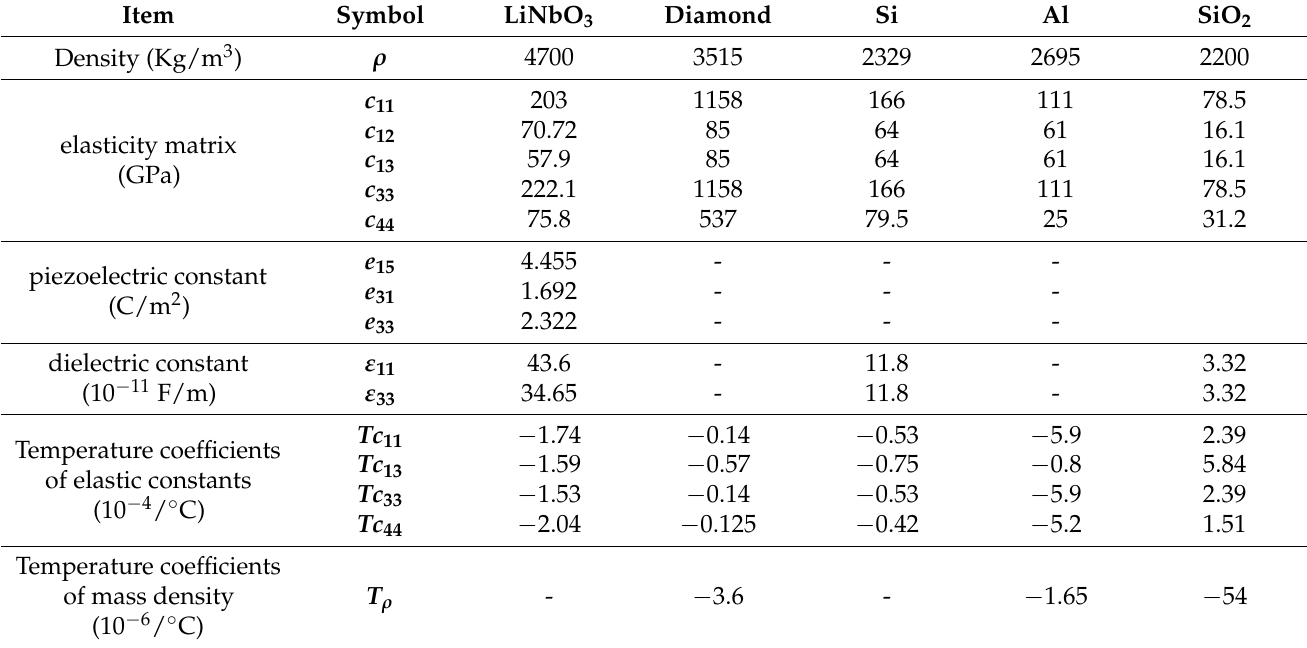
Table 2. Material constants used in the